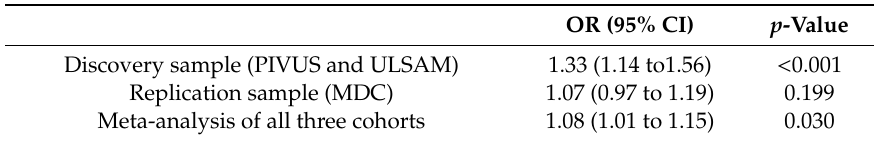
Figure 2. Associations between 79 proteins and blood pressure progression in the Prospective Investigation of the Vasculature in Uppsala Seniors (PIVUS) Study and the Uppsala Longitudinal Study of Adult Men (ULSAM) study. Data are odds ratios (ORs) and 95% confidence intervals (95% CIs). Table 2. Associations of renin and blood pressure progression in the discovery sample (PIVUS and ULSAM) and replication sample